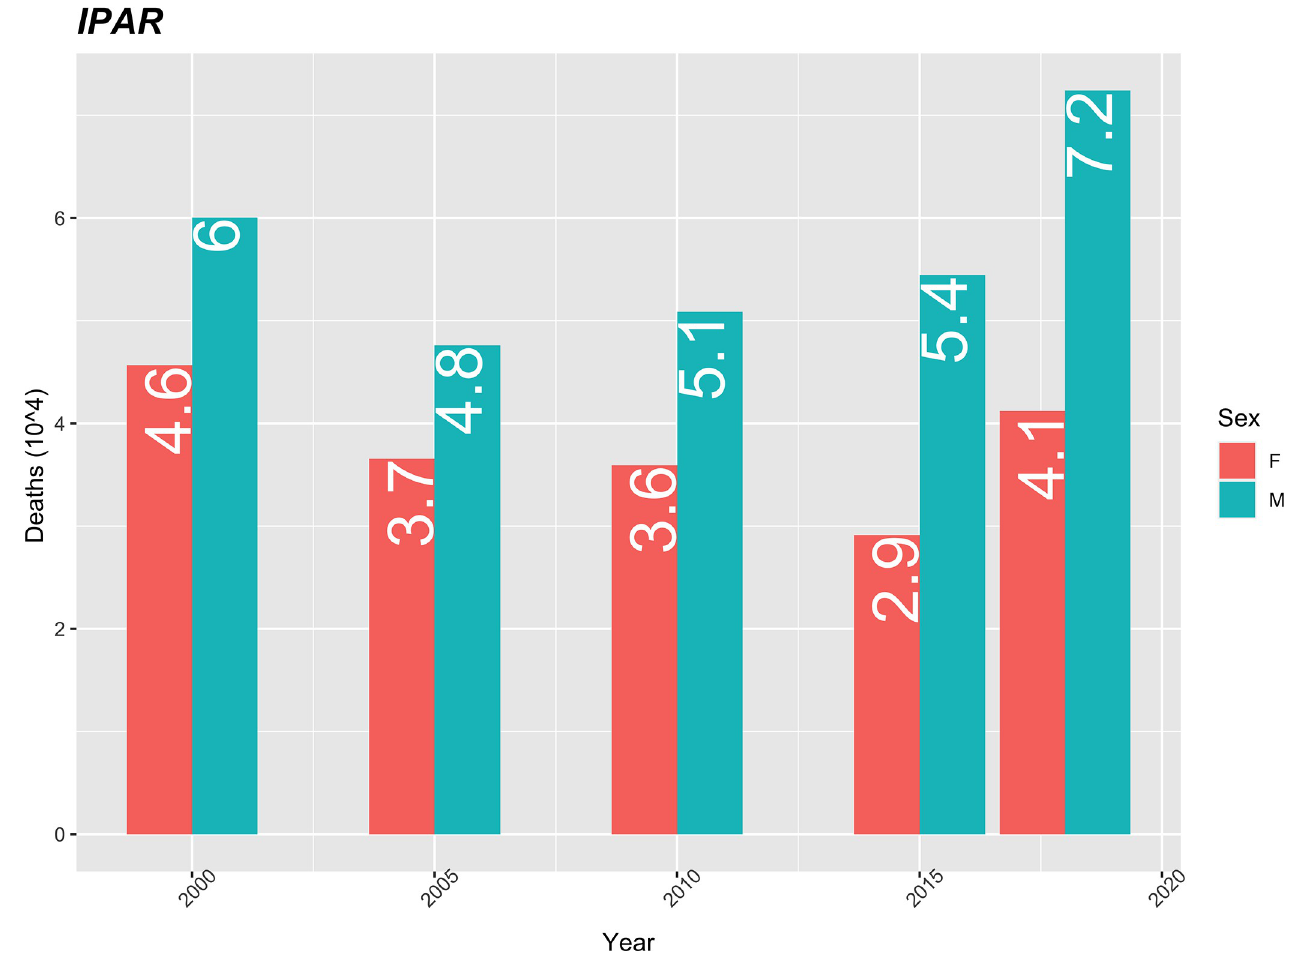
Fig 8. Mortality rate per IPAR (10 thousand) standardized by age, using the population of Cape Verde in 2010 as the standard.